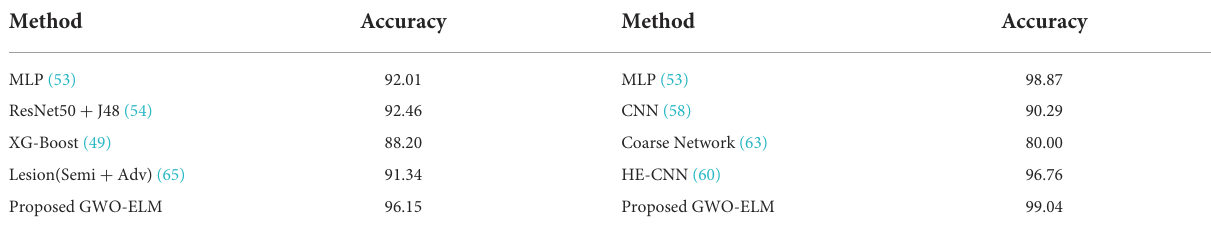
Accuracy results based on IDRiD dataset with 5